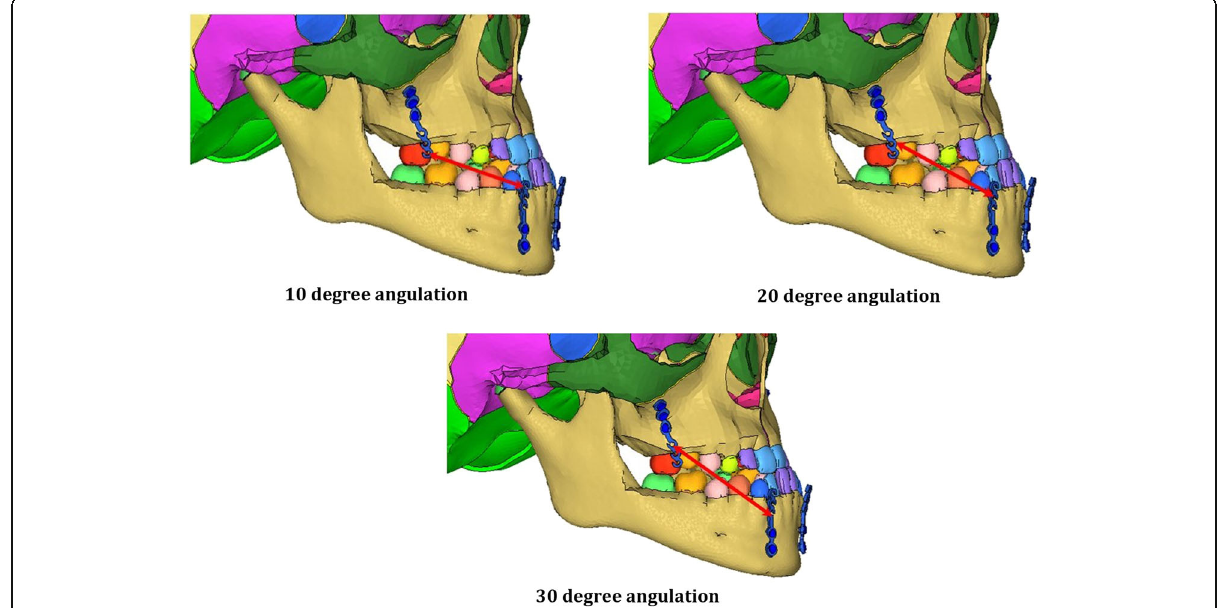
Fig. 3 Finite element analysis with the three angulations of elastics (10° to